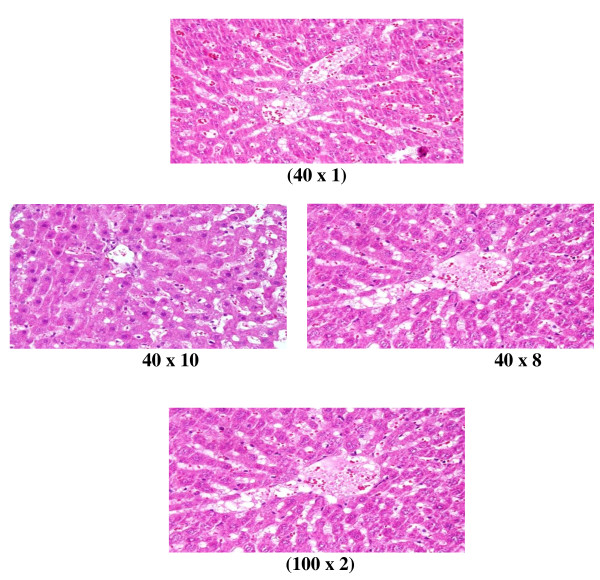
GNPs-treated rat received 50 μl of 50 nm particles for 3 days